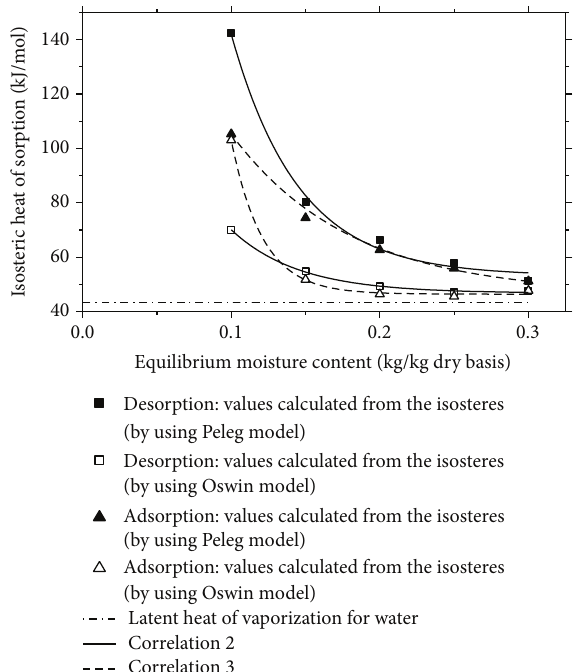
Figure 6: Variations of calculated and experimental values of desorption and adsorption isosteric heats of Ziziphus spina-christi leaves versus equilibrium moisture